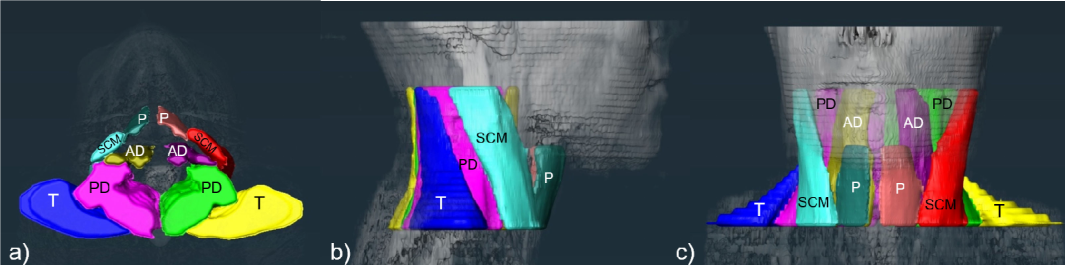
Figure 1. Three-dimensional reconstruction of MRI muscle volume segmentations (case 41) in ( a ) axial, ( b ) right sagittal, and ( c ) coronal views: trapezoid muscle (“T”, right side blue, left side yellow), posterior deep muscles (“PD”, right side pink, left side green), anterior deep muscles (“AD”, right side dark yellow, left side purple), sternocleidomastoid muscle (“SCM”, right side light turquoise, left side red), and pretracheal muscles (“P”, right side dark turquoise, left side